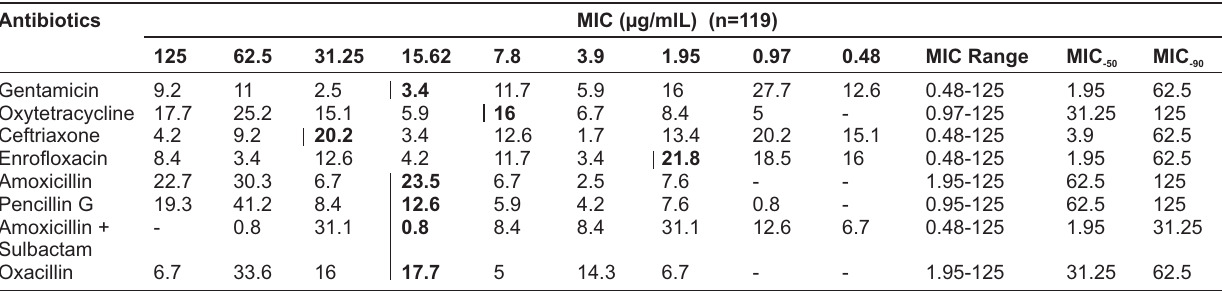
Table-2: MIC of drugs against (n=119) isolated from udder of cows E. coli Antibiotics